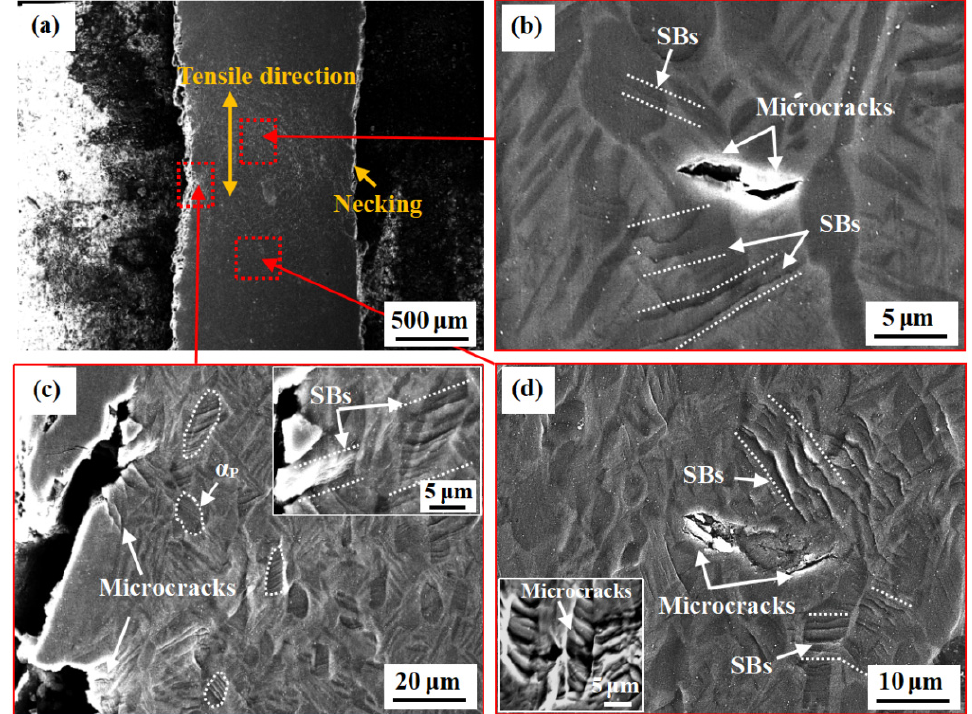
Figure 6. ( a ) In situ SEM images of bimodal microstructure at B (the displacement of 726 µ m); ( b ) microcracks become deepened and widened; ( c ) magnified image showing macrocracks nucleated at the edge of the sample; ( d ) distortion in SB regions and microcracks at α P / β interface.